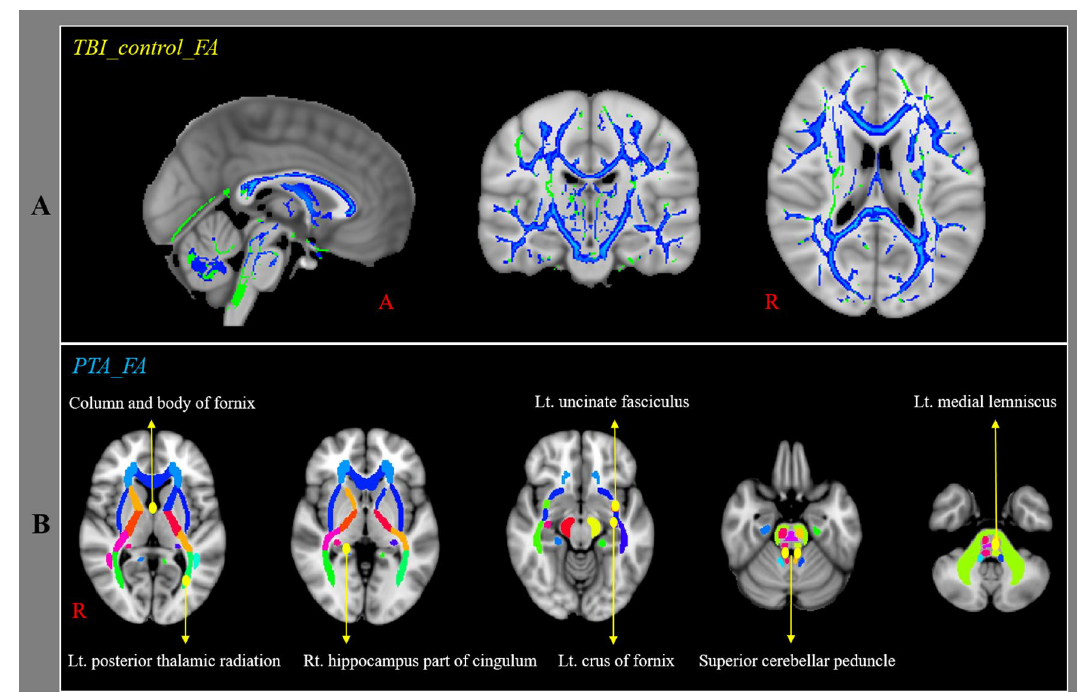
Figure 1. Results of tract-based spatial statistics analyses comparing the fraction anisotropy (FA) values of the patients and control groups and the correlation between post-traumatic amnesia (PTA) duration and FA values of patients. FA values were obtained for 48 regions of interest (ROIs) using a standard template of the John Hopkins University diffusion tensor imaging-based white matter atlases within the Functional Magnetic Resonance Imaging of the Brain Software Library (FSL version 5.1; www. fmrib. ox. ac. uk/ fsl). ( a ) The blue voxels indicate areas with higher mean FA values in the control group than in the patient group. ( b ) Among the 48 ROIs, the FA values of eight ROIs (column and body of fornix, left crus of fornix, left uncinate fasciculus, right hippocampus part of cingulum, left medial lemniscus, right superior cerebellar peduncle, left superior cerebellar peduncle, left posterior thalamic radiation including optic radiation) in the patient group were negatively correlated with